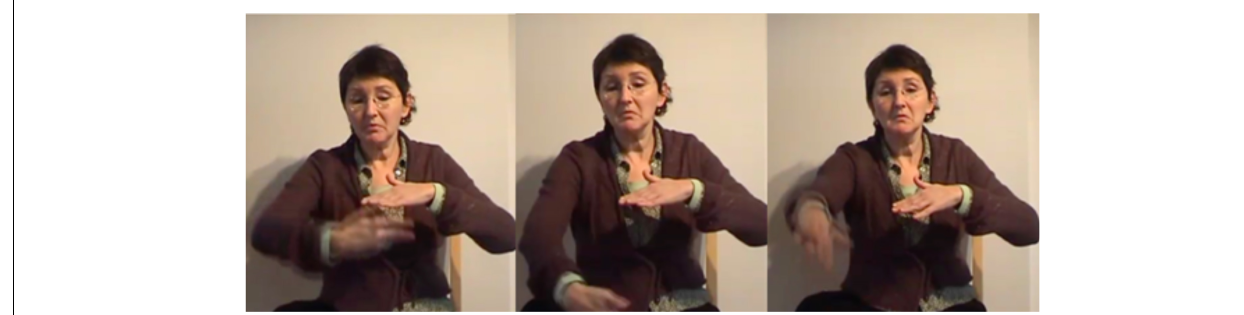
in order to foreground the descriptive, depictive and/or indexical reading. This semiotic account of depiction does then also have